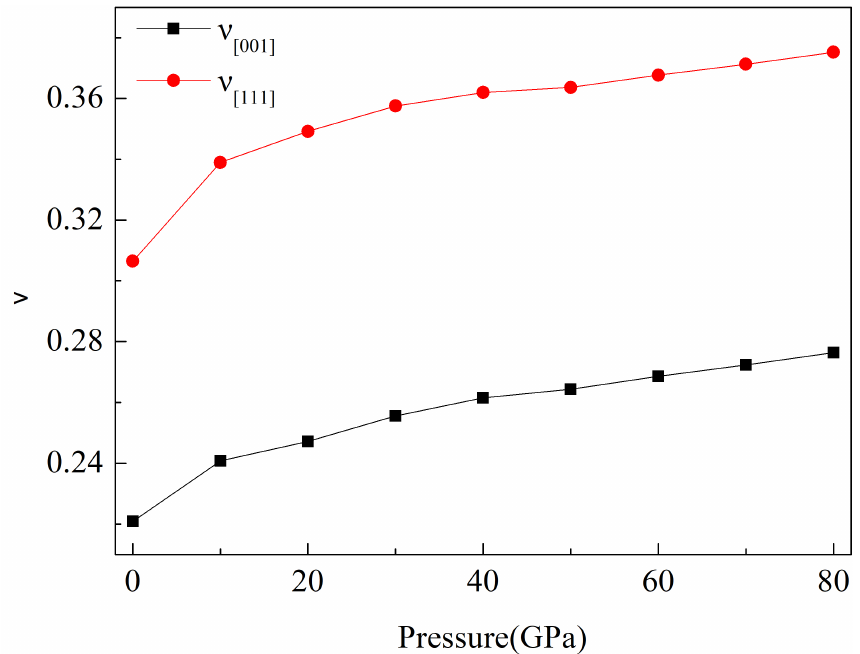
Figure 9. The Poisson’s ratio as a function of applied pressure for β -Mg 17 Al 12